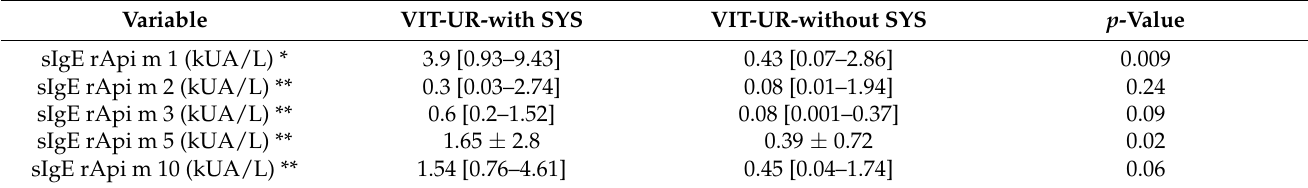
Table 6. Comparison of serum levels of specific IgE against bee venom allergen molecules among patients with and without allergic side effects in the induction phase of bee venom